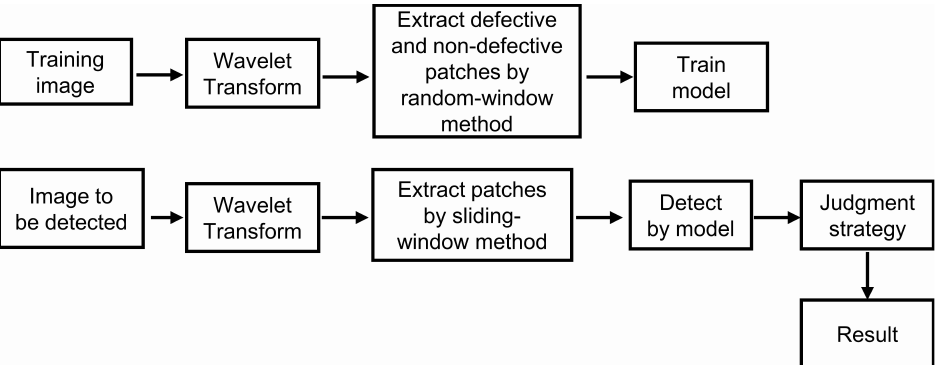
Figure 1. The general process of this paper’s method. The wavelet-transformed images are extracted as defective and non-defective patches, respectively. Feed it into the network to train the model. When testing, use a sliding window to input the wavelet-transformed image into the model for judgment and